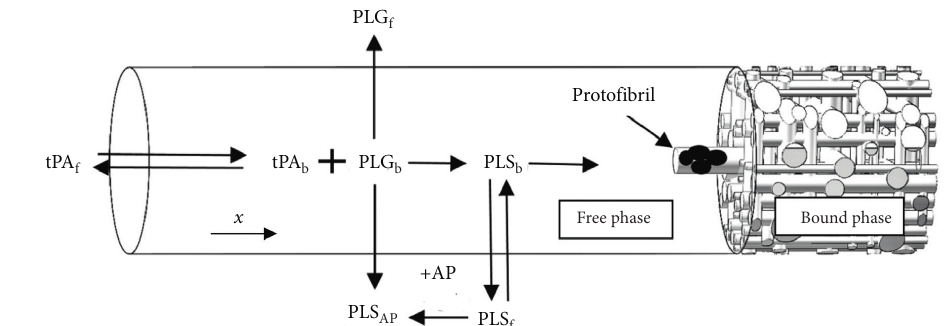
Figure 3: The process of thrombolysis.